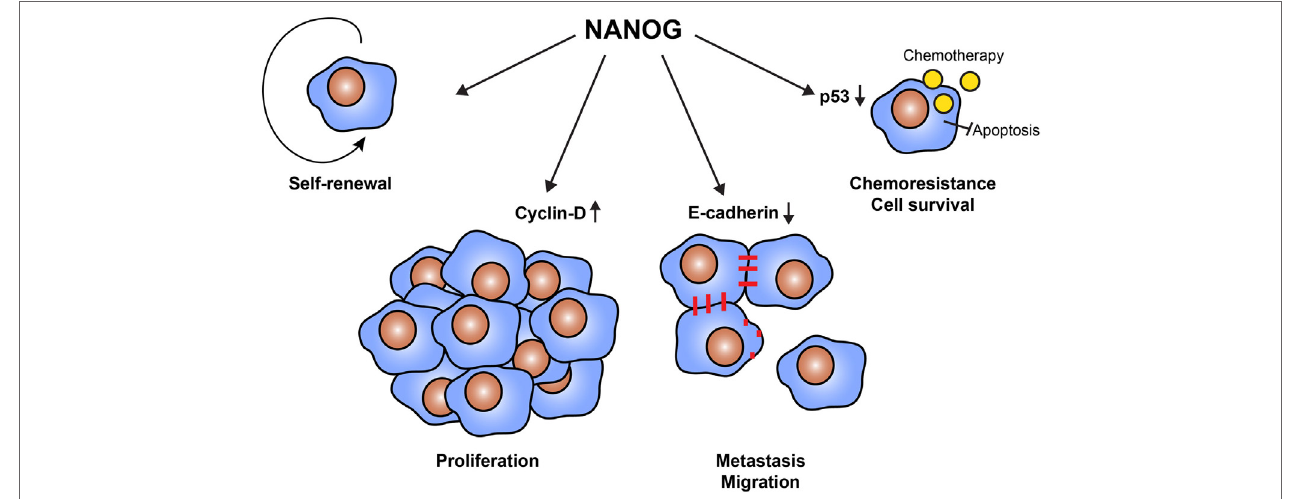
FiGUre 1 | Cellular functions of NANOG in cancer stem cells (CSCs). The transcription factor NANOG is expressed by CSCs and has a variety of functions. NANOG is essential to maintain the self-renewal properties of CSCs. Furthermore, NANOG regulates cell proliferation via the interaction with cell cycle proteins, such as cyclin D. It also downregulates the expression of E-cadherin, enabling cells to detach and migrate to form distant metastases. Finally, NANOG promotes cell survival and resistance to therapy. NANOG interferes with the tumor suppressor p53, protecting cells from